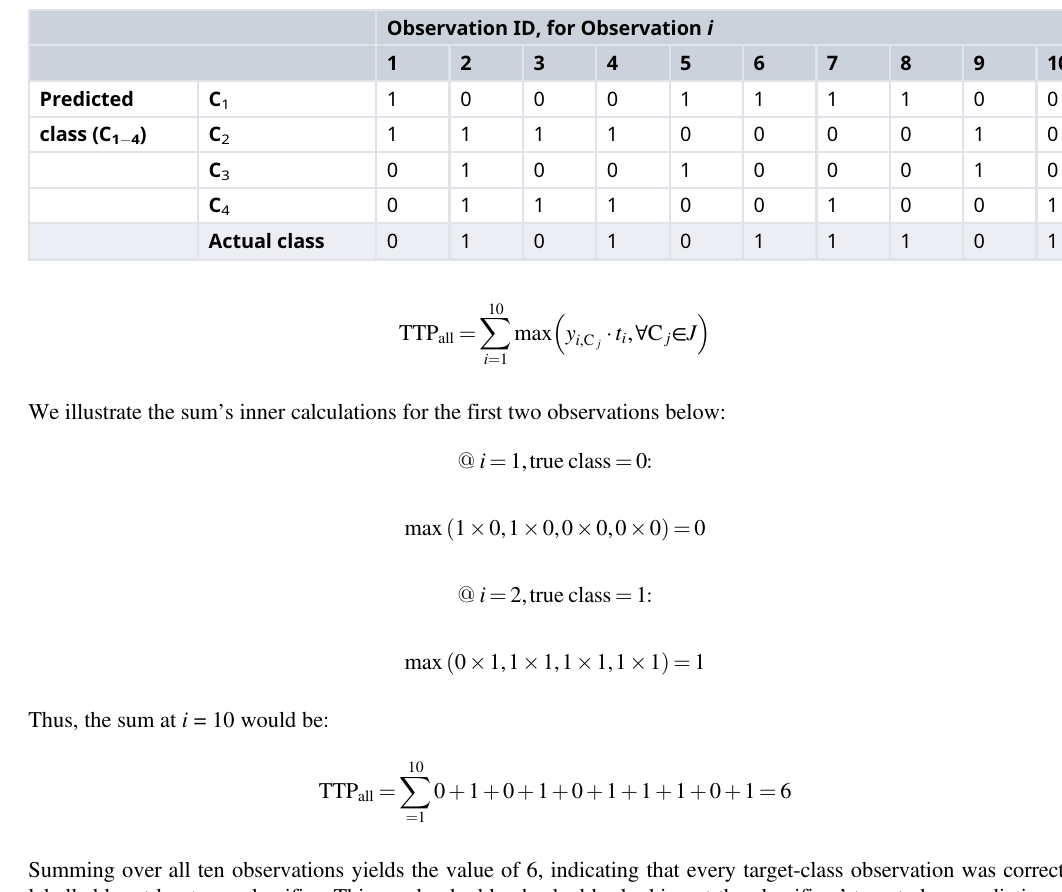
Table 2. Sample classifier prediction matrix.